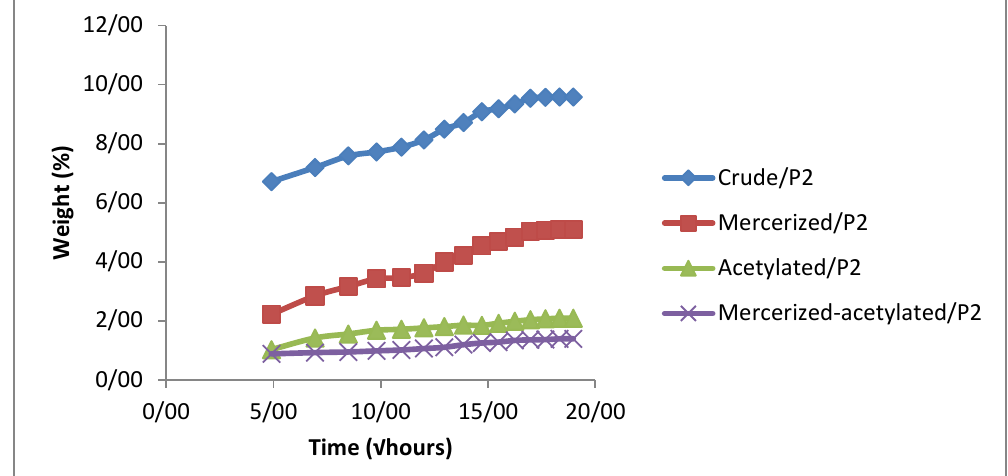
Fig. 2. Moisture absorption behaviour over time for P2 fibre contents.